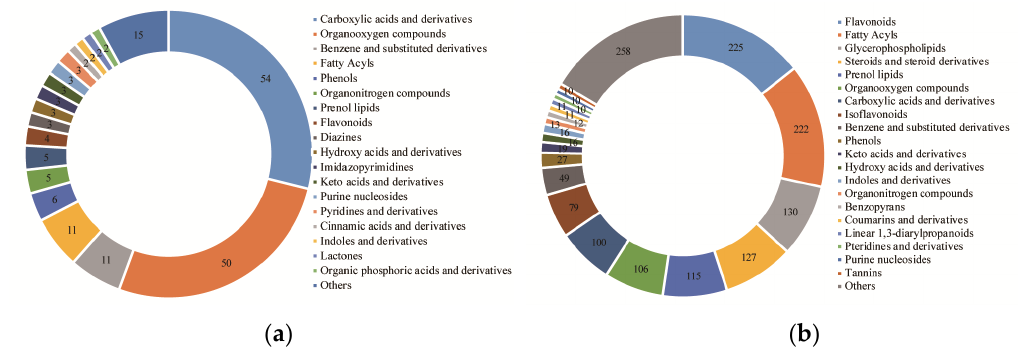
Figure 2. A classification of the metabolites during developing S. tonkinensis kernels. ( a ) The clustering results based on the metabolites of GC-MS analyses. ( b ) The clustering results based on the metabolites of LC-MS analyses.